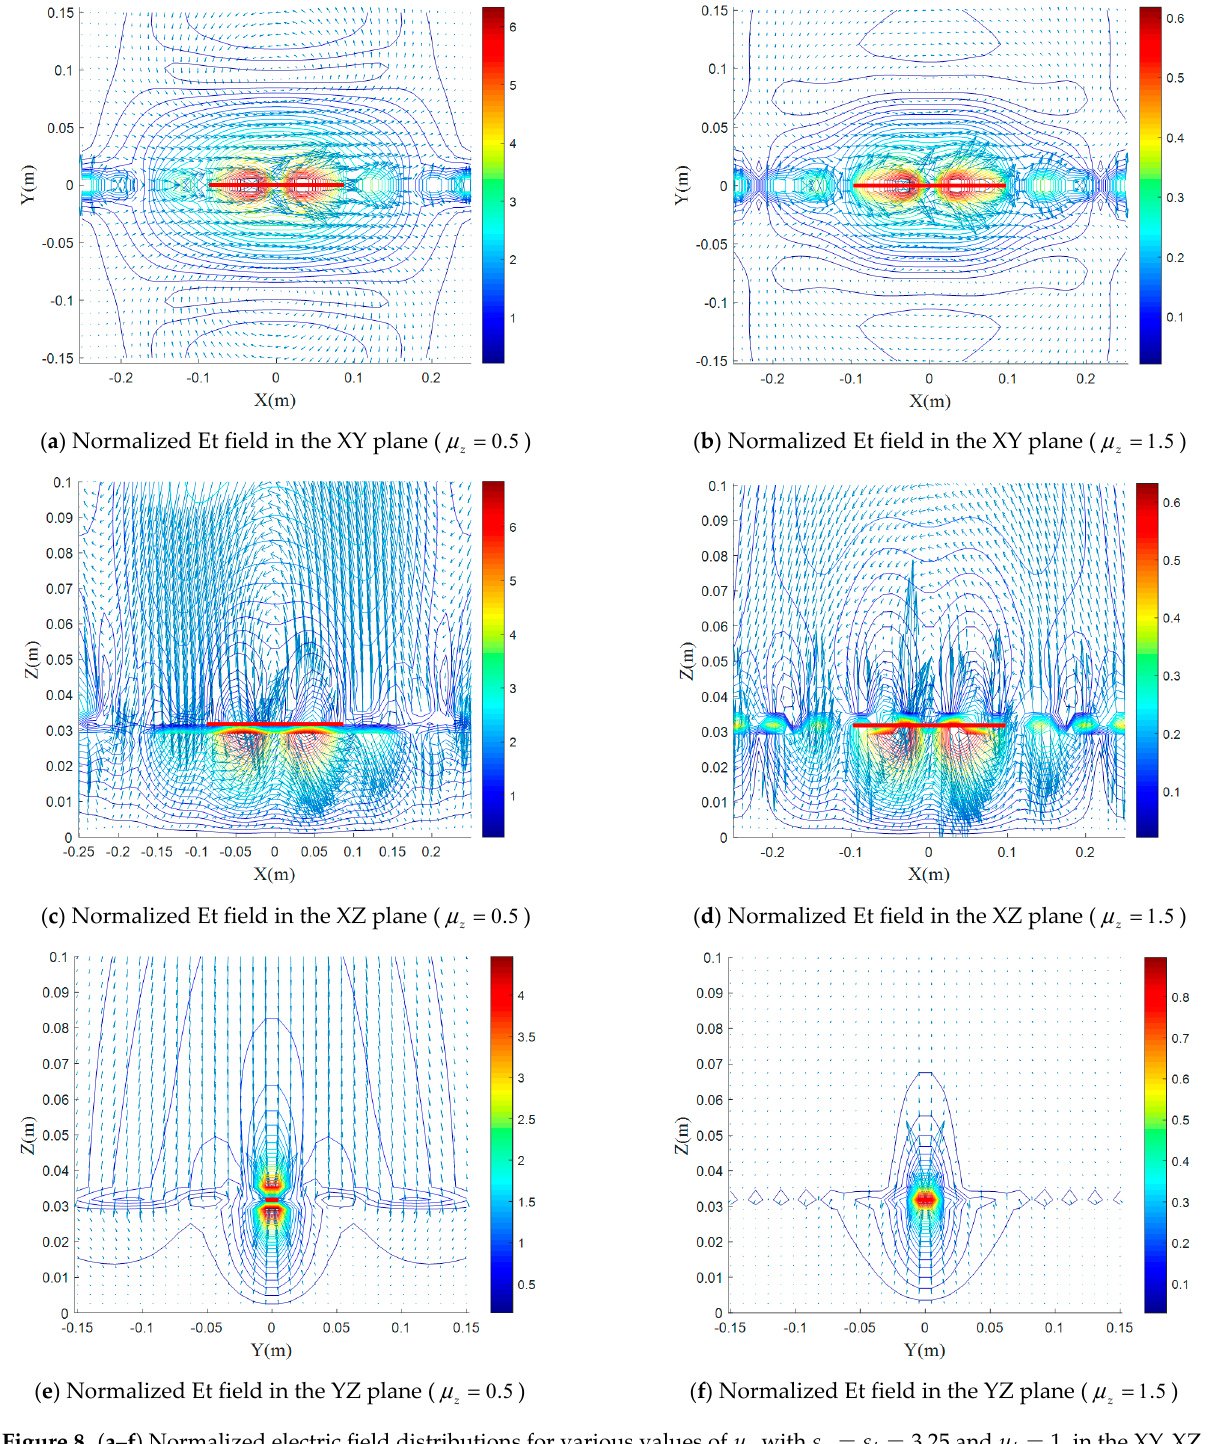
Figure 8. ( a – f ) Normalized electric field distributions for various values of µ z with ε z = ε t = 3.25 and µ t = 1, in the XY, XZ, and YZ planes.